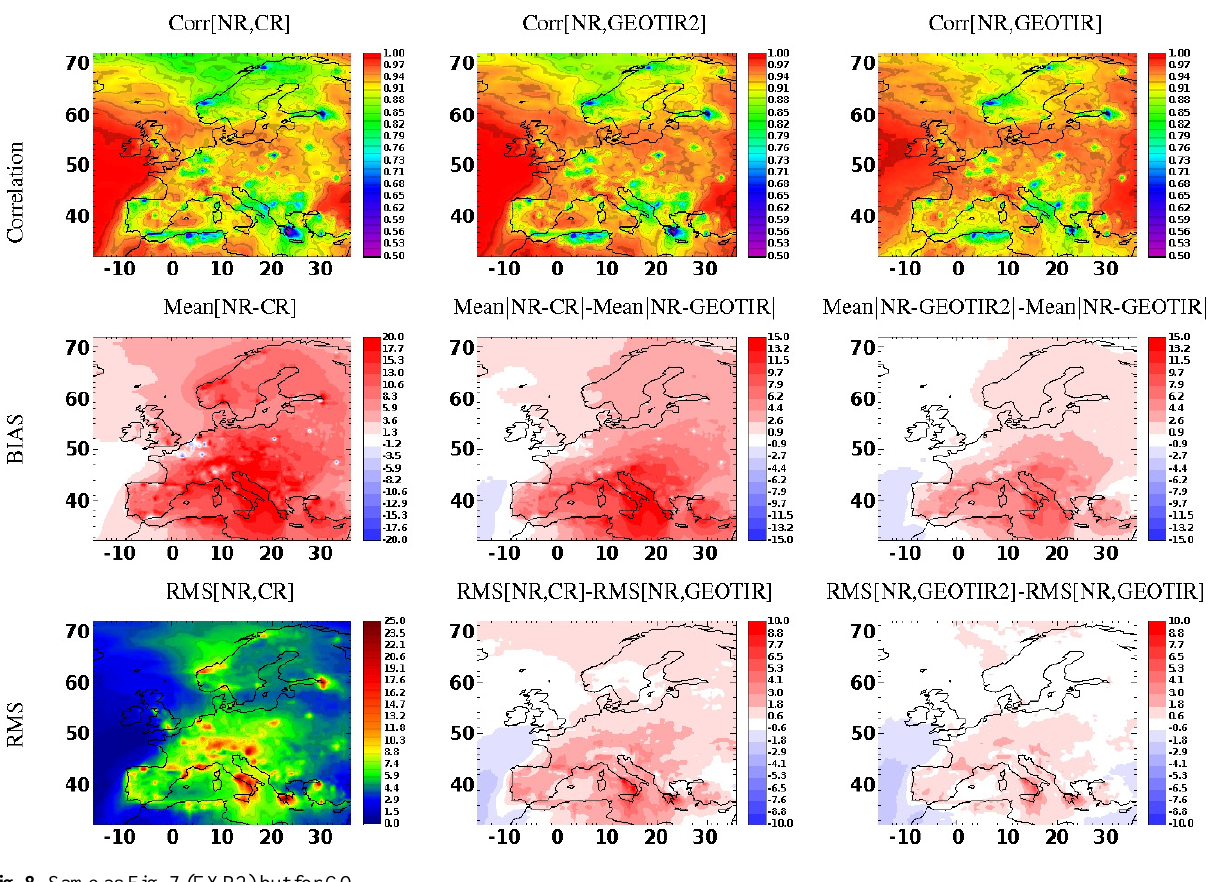
Fig. 8. Same as Fig. 7 (EXP2) but for